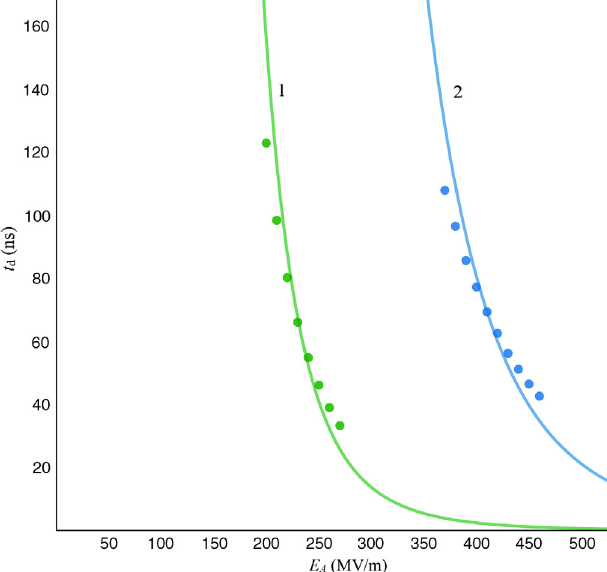
FIG. 2. Delay time t d as a function of the electric field amplitude E A , at the surface of an rf accelerating structure for different values of the field enhancement factor: β ¼ 77 (1) and 50 (2); curves represent the relation t d ð β electric field oscillation frequency ν ¼ 10